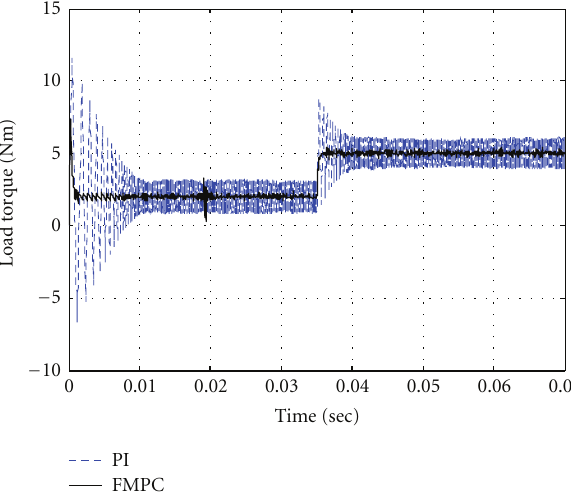
Figure 9: Torque response based on FMPC and PI controllers at low